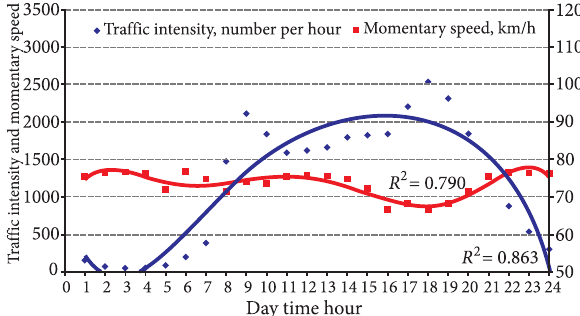
Fig. 1. Relation of traffic volume and momentary speed at regulation speed of 70 km/h